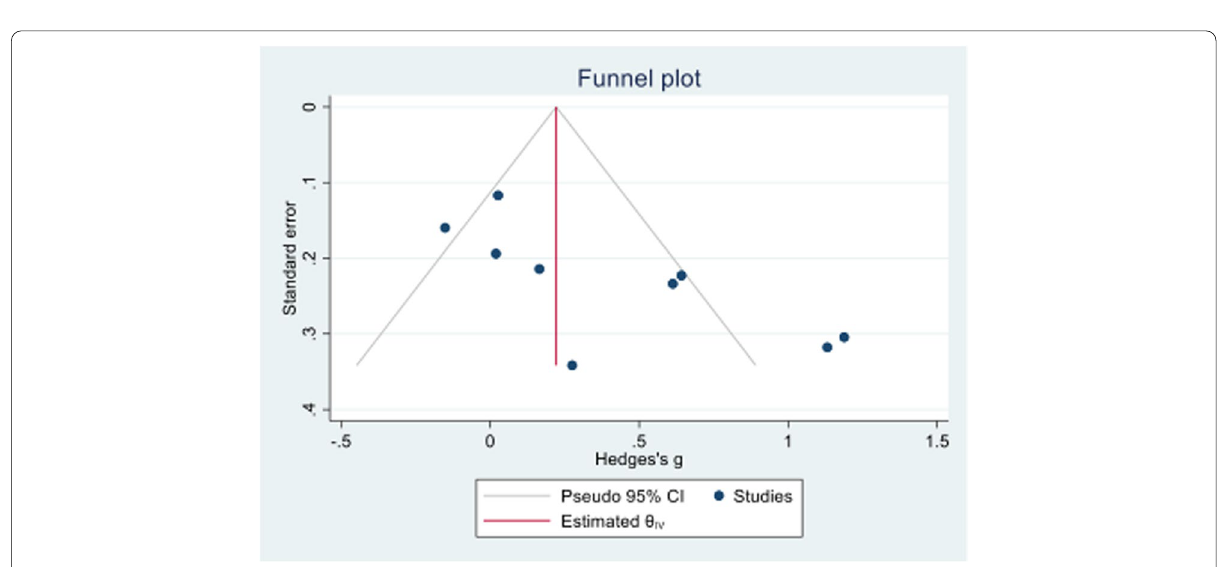
Fig. 2 Funnel plot for testing publication